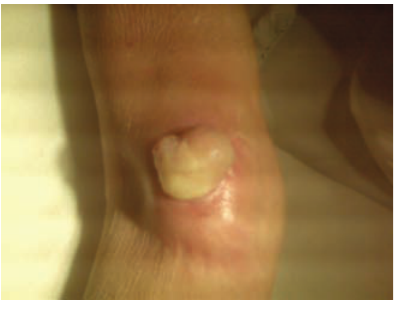
Figure 1. Appearance of the right antecu- bital fossa prior to surgical resection.